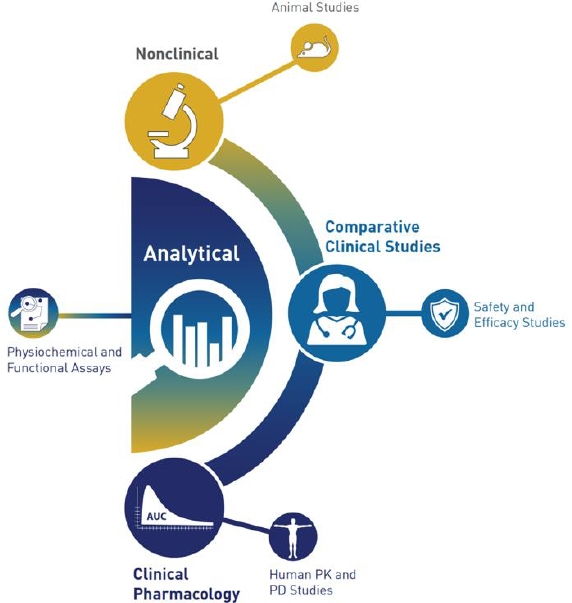
Figure 2. The new FDA rollout of the development crescent for biosimilars (FDA: Level 1 Biosimilar and Interchangeable Products Foundational Concepts (https://www.fda.gov/drugs/biosimilars/curriculum-materials-health-care-degree-programs-biosimilars; accessed on 4 April 2022).